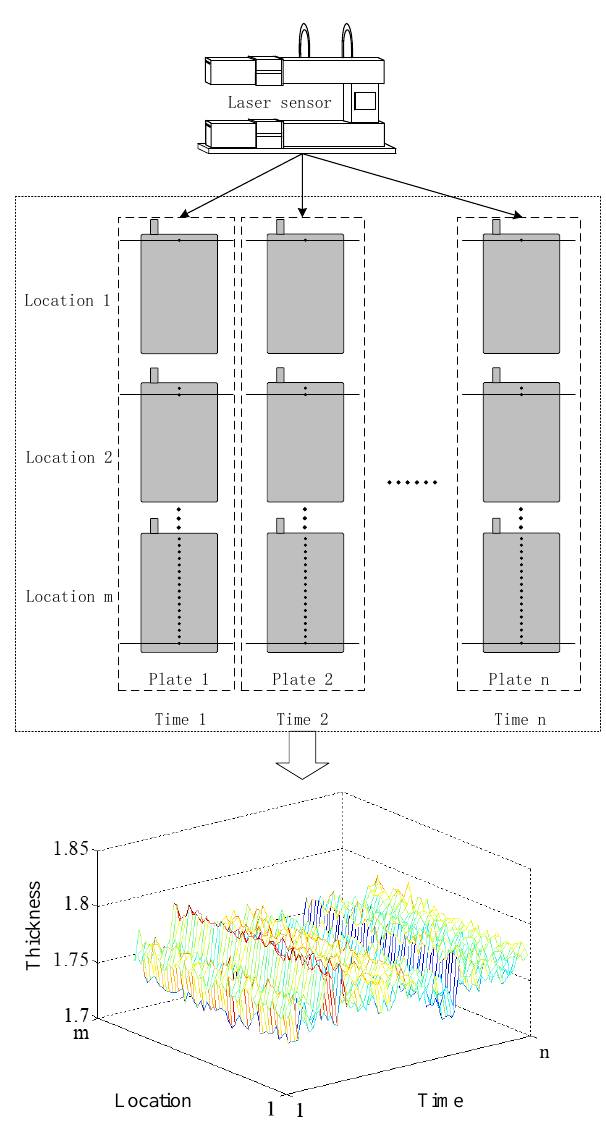
Figure 2. Spatial-temporal data collection in the pasting